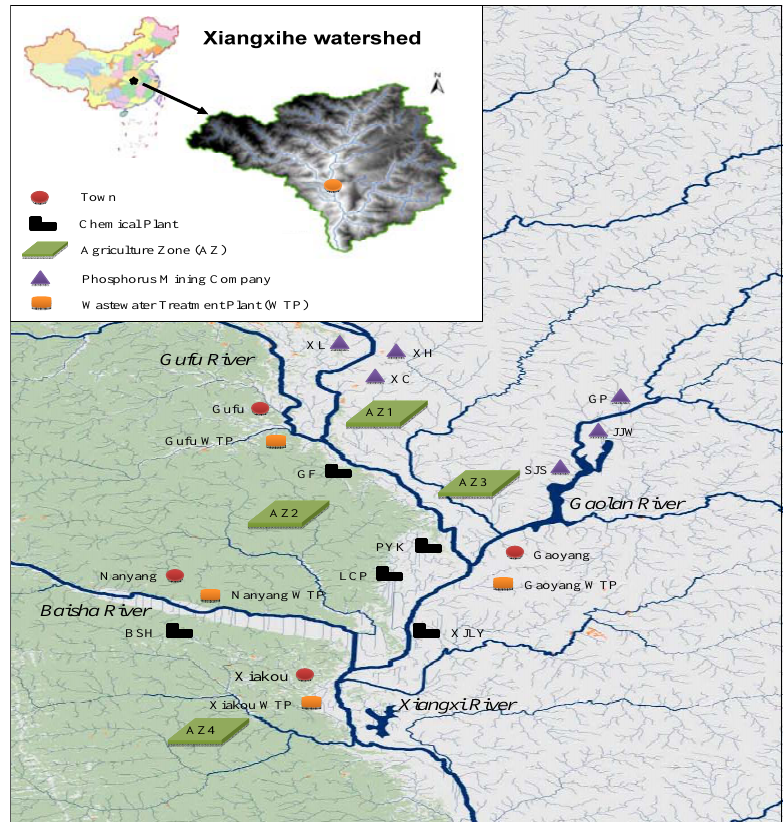
Figure 2. Study area. Note: GF, Gufu chemical plant; XL, Xinglong phosphorus mining company; XH, Xinghe phosphorus mining company; XC, Xingchang phosphorus mining company; BSH, Baishahe